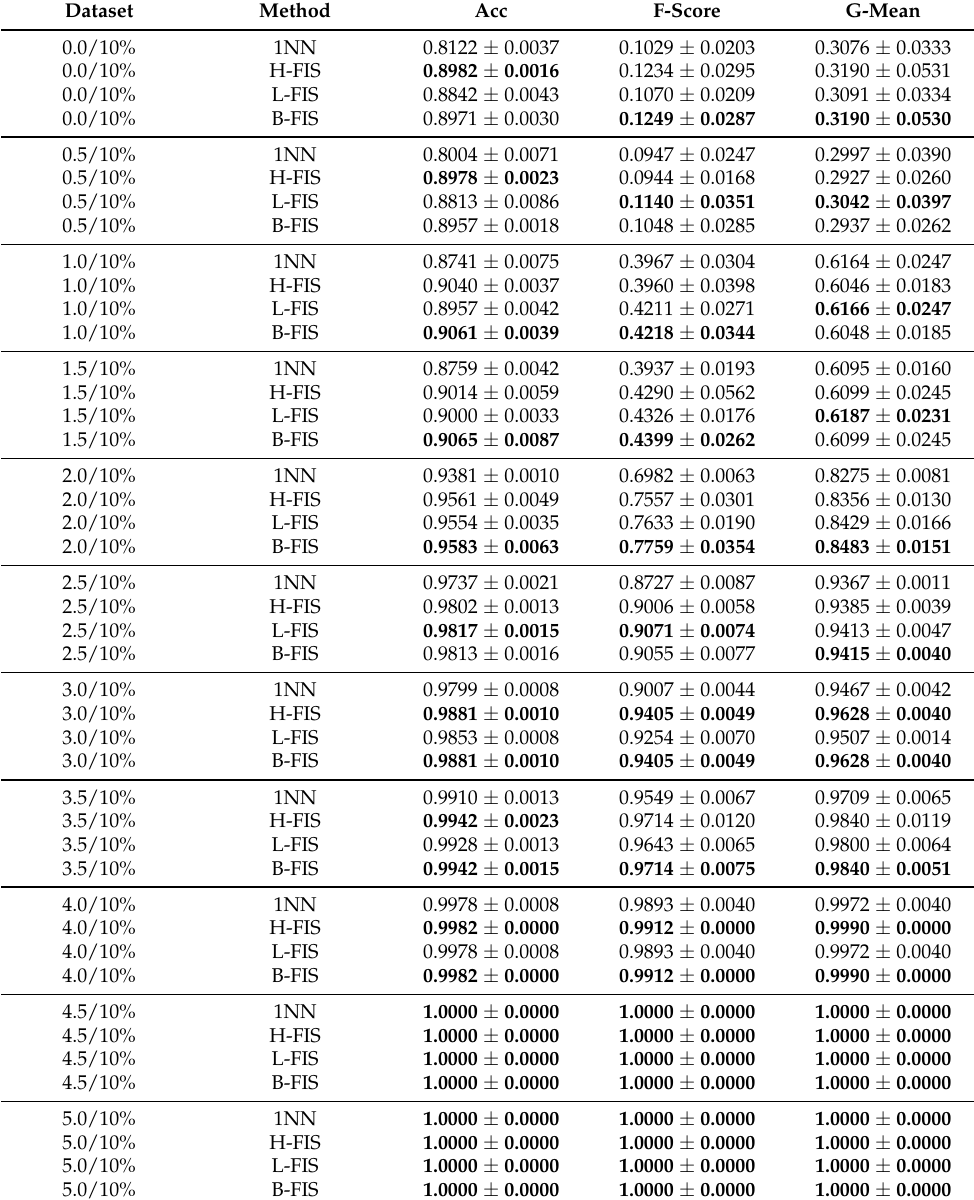
Table 6. Results for artificial dataset with 10% of positive